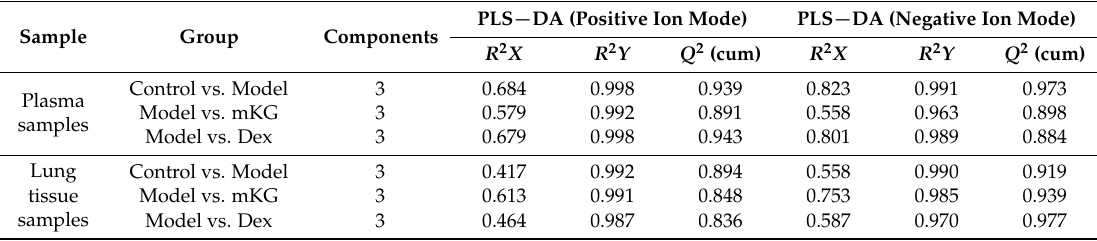
Table 1. The parameters for assessing the modeling quality of PLS − DA in positive and negative ion modes of plasma and lung tissue samples.